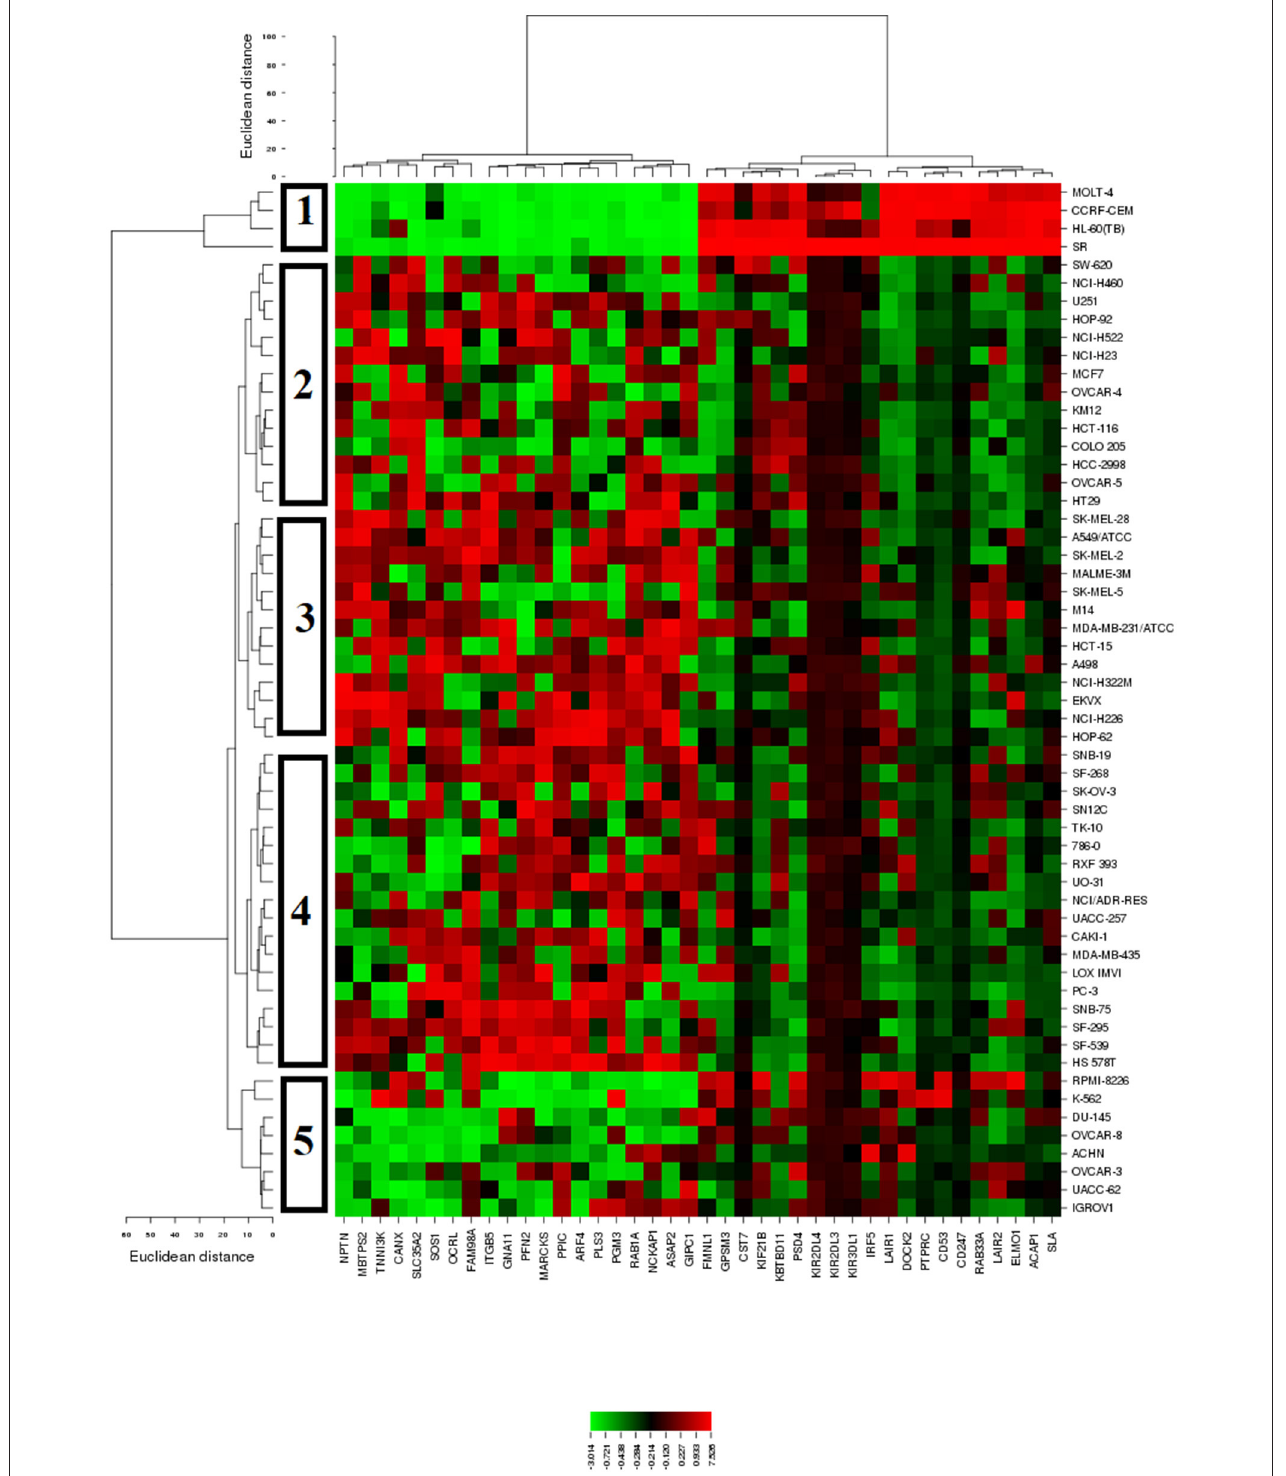
FIGURE 4 | Dendrograms and heatmap of sanguinarine obtained by hierarchical cluster analyses of NCI cells line panel and genes whose mRNA expression directly or inversely correlated with the log 10 IC 50 values for sanguinarine. The dendrogram on the left shows the clustering of cell lines and the dendrogram on the top shows the clustering of